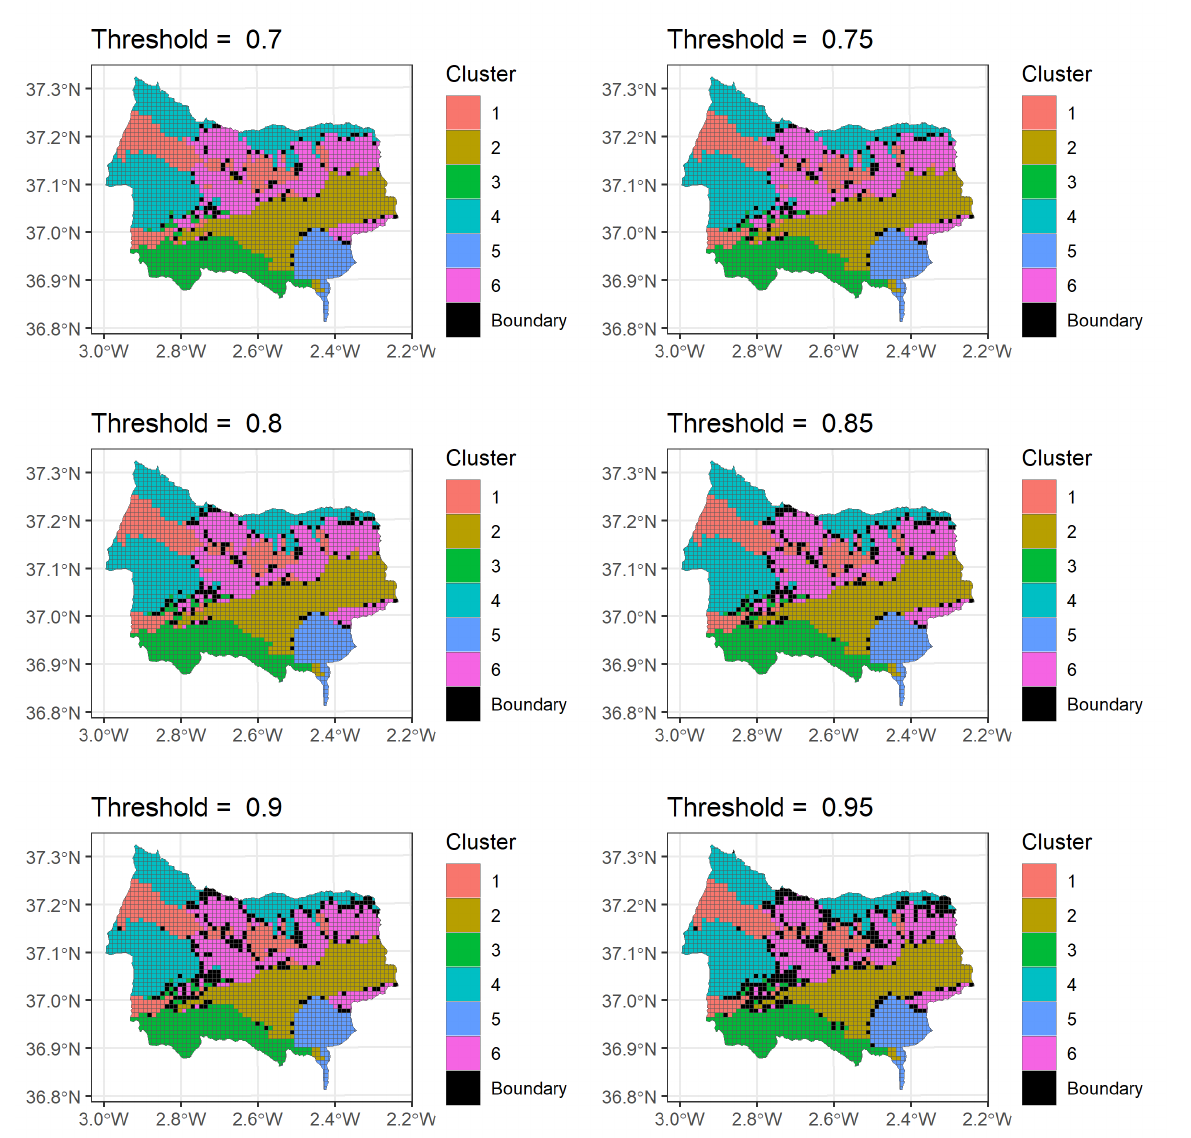
Figure 4. Grid cells classified as boundaries (black color) according to different probabilistic